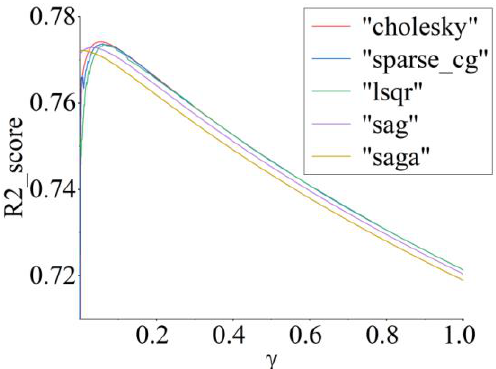
Figure 11. Joint analysis of gradient solver and for vibration measurement by SMI.